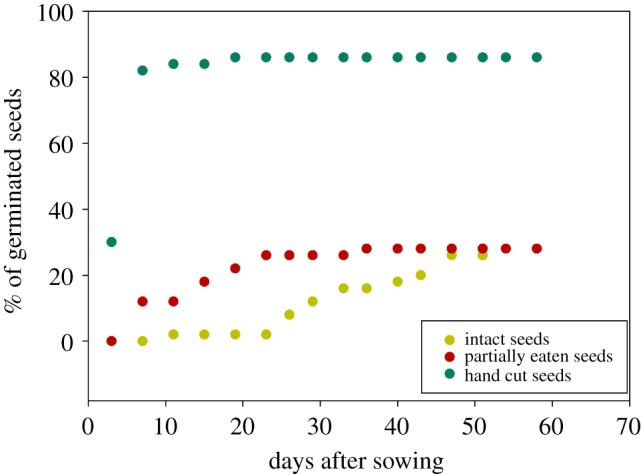
Proportion of germinated seeds in relation to days passed after sowing for three treatments. Total seeds in each treatment = 50.